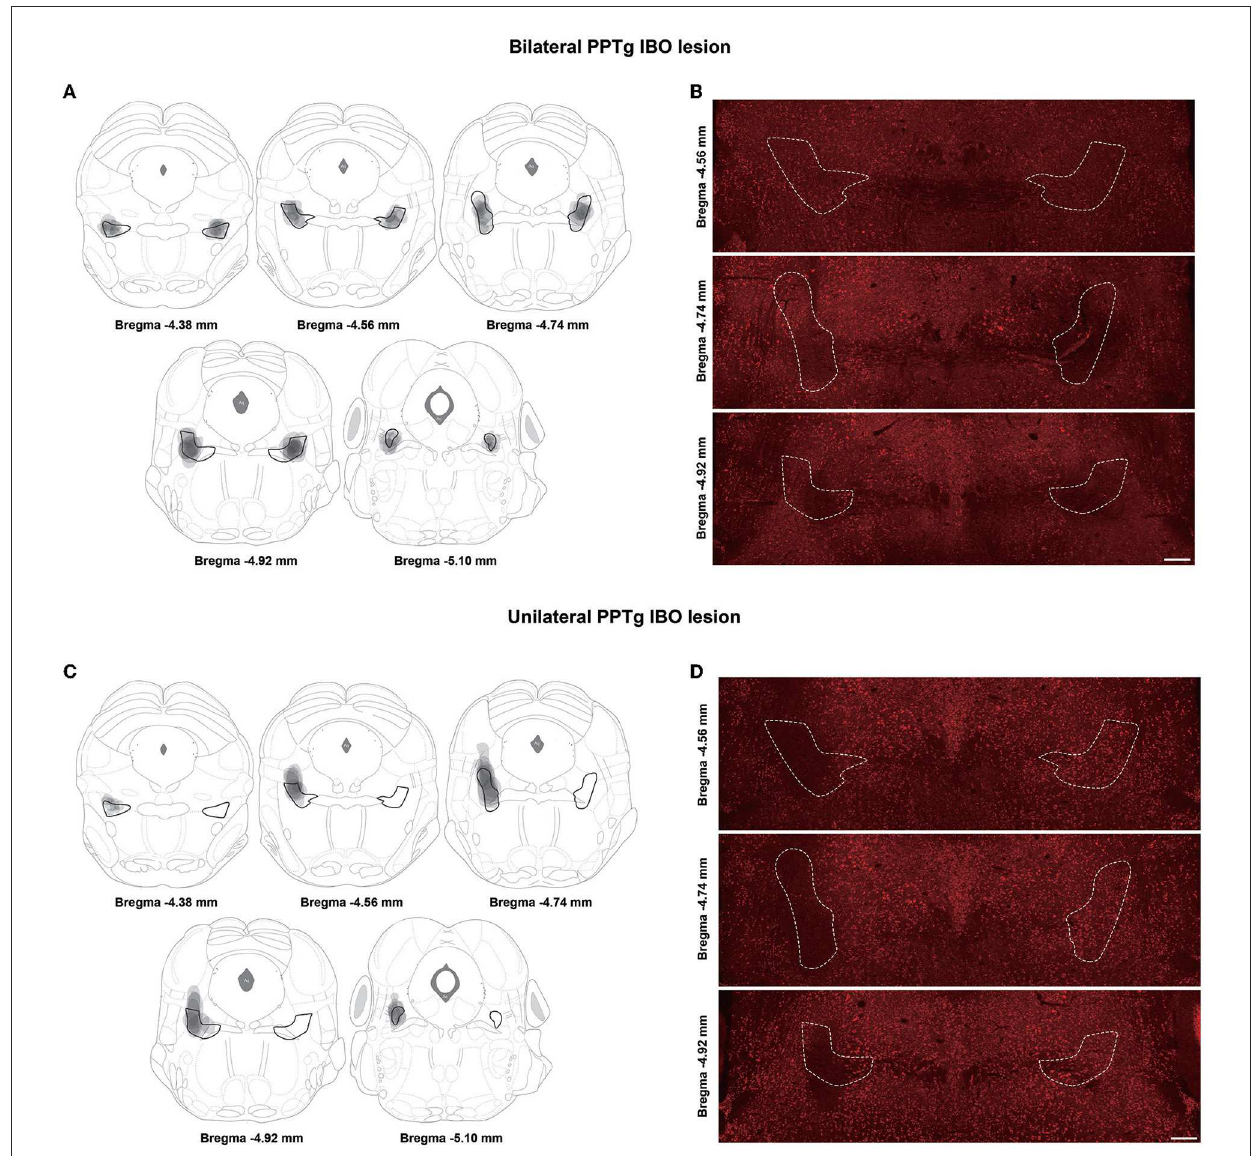
FIGURE2 Lesioned areas in different layers of the PPTg for bilateral and unilateral PPTg IBO lesioned mice. (A) The overlay of lesioned areas in the bilateral PPTg IBO lesioned group is drawn according to the neuronal nuclei (NeuN) staining. The PPTg is outlined in black and every lesioned area is drawn in gray. (B) Representative photographs of NeuN staining in different layers of the PPTg for bilateral IBO lesioned mice. The PPTg is outlined in the dashed line. (C) The overlay of lesioned areas in the unilateral PPTg IBO lesioned group is drawn according to the NeuN staining. (D) Representative photographs of NeuN staining in different layers of the PPTg for unilateral IBO lesioned mice. Scale bar = 1000 µ